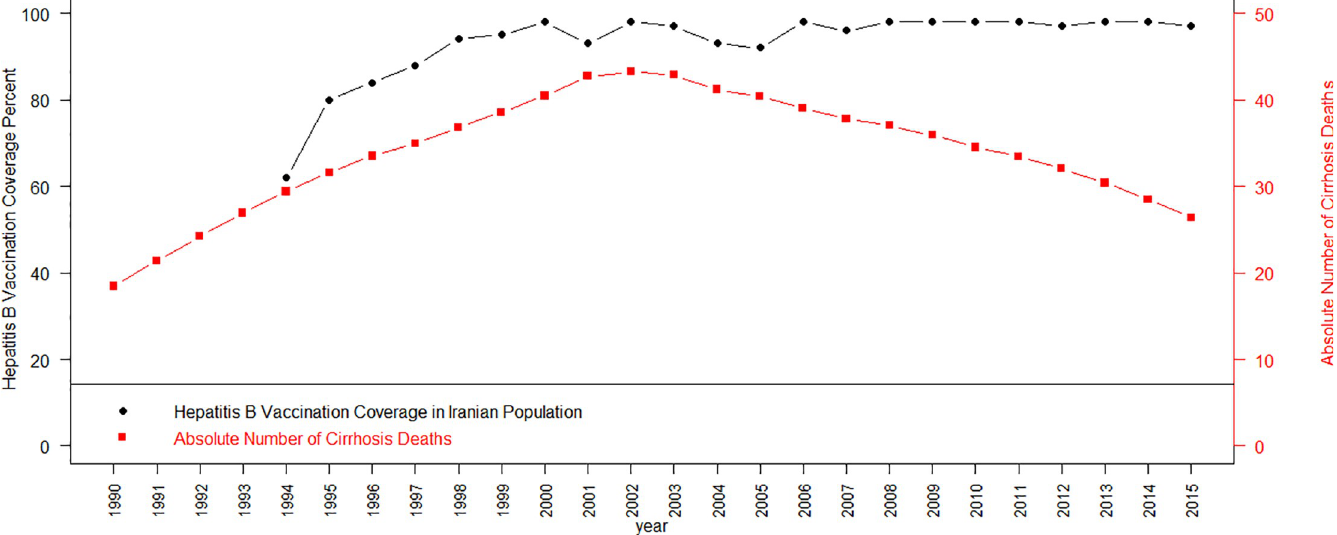
Fig 2. Percentage of hepatitis B vaccination coverage in Iran from 1993 to 2015 and absolute number of deaths due to cirrhosis in Iran.